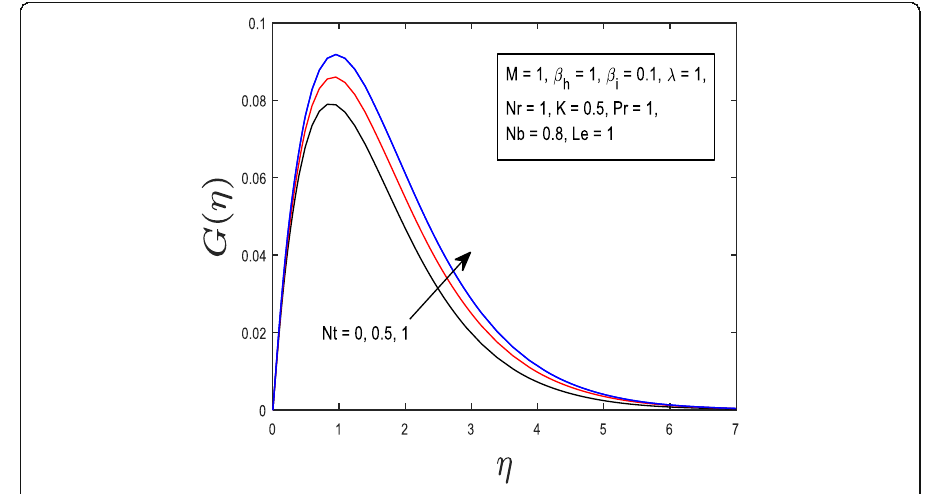
Fig. 23 Graph of cross flow velocity for various values of Nt